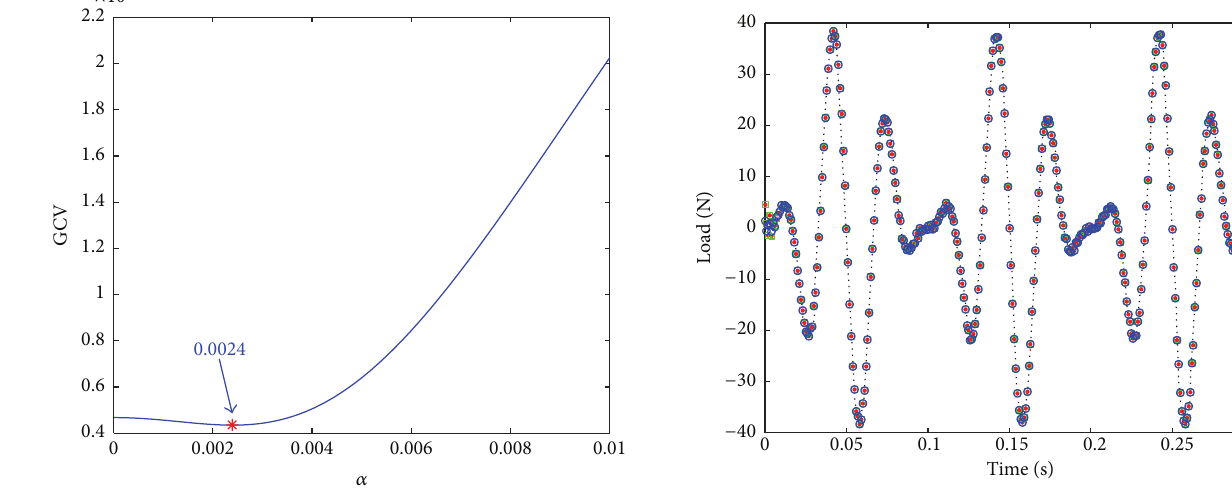
Figure 3: GCV for AM load identification of SISO system.